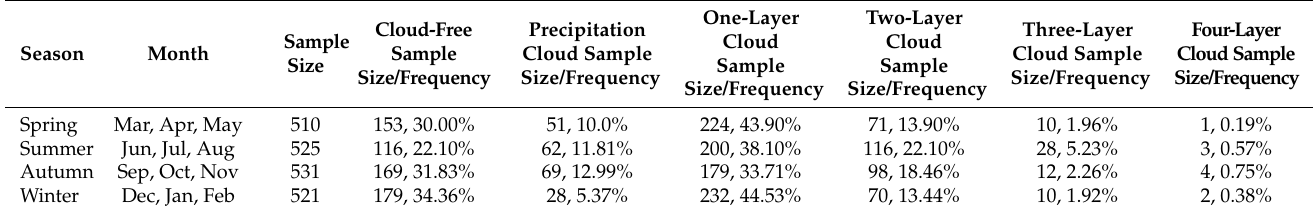
Figure 18. Variation trends in the average CTH and CBH for each month from 2019 to 2021. ( a ) Blue represents the average CTH and ( b ) red represents the average CBH (each boxplot shows the minimum, first quartile, median, third quartile, and maximum). Table 3. Cloud distribution from 2019 to